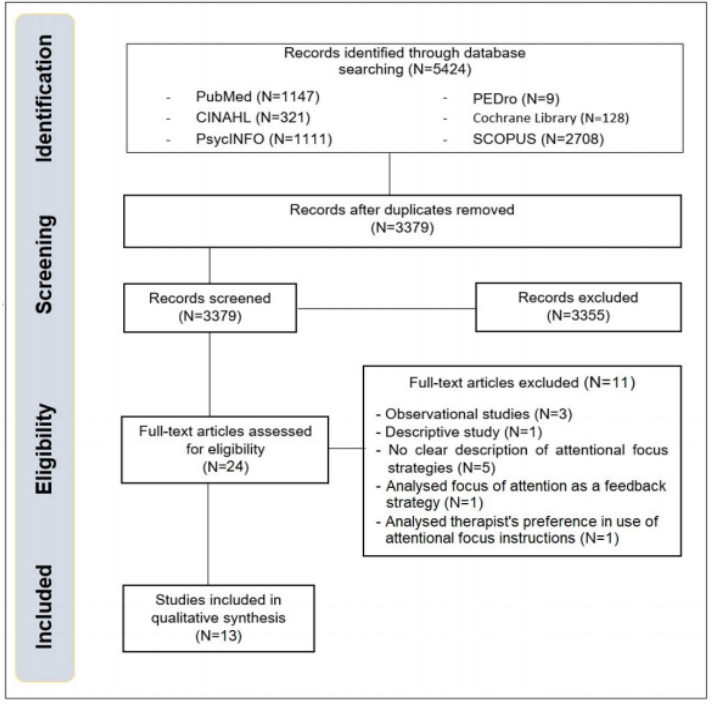
Figure 1. PRISMA flow diagram.